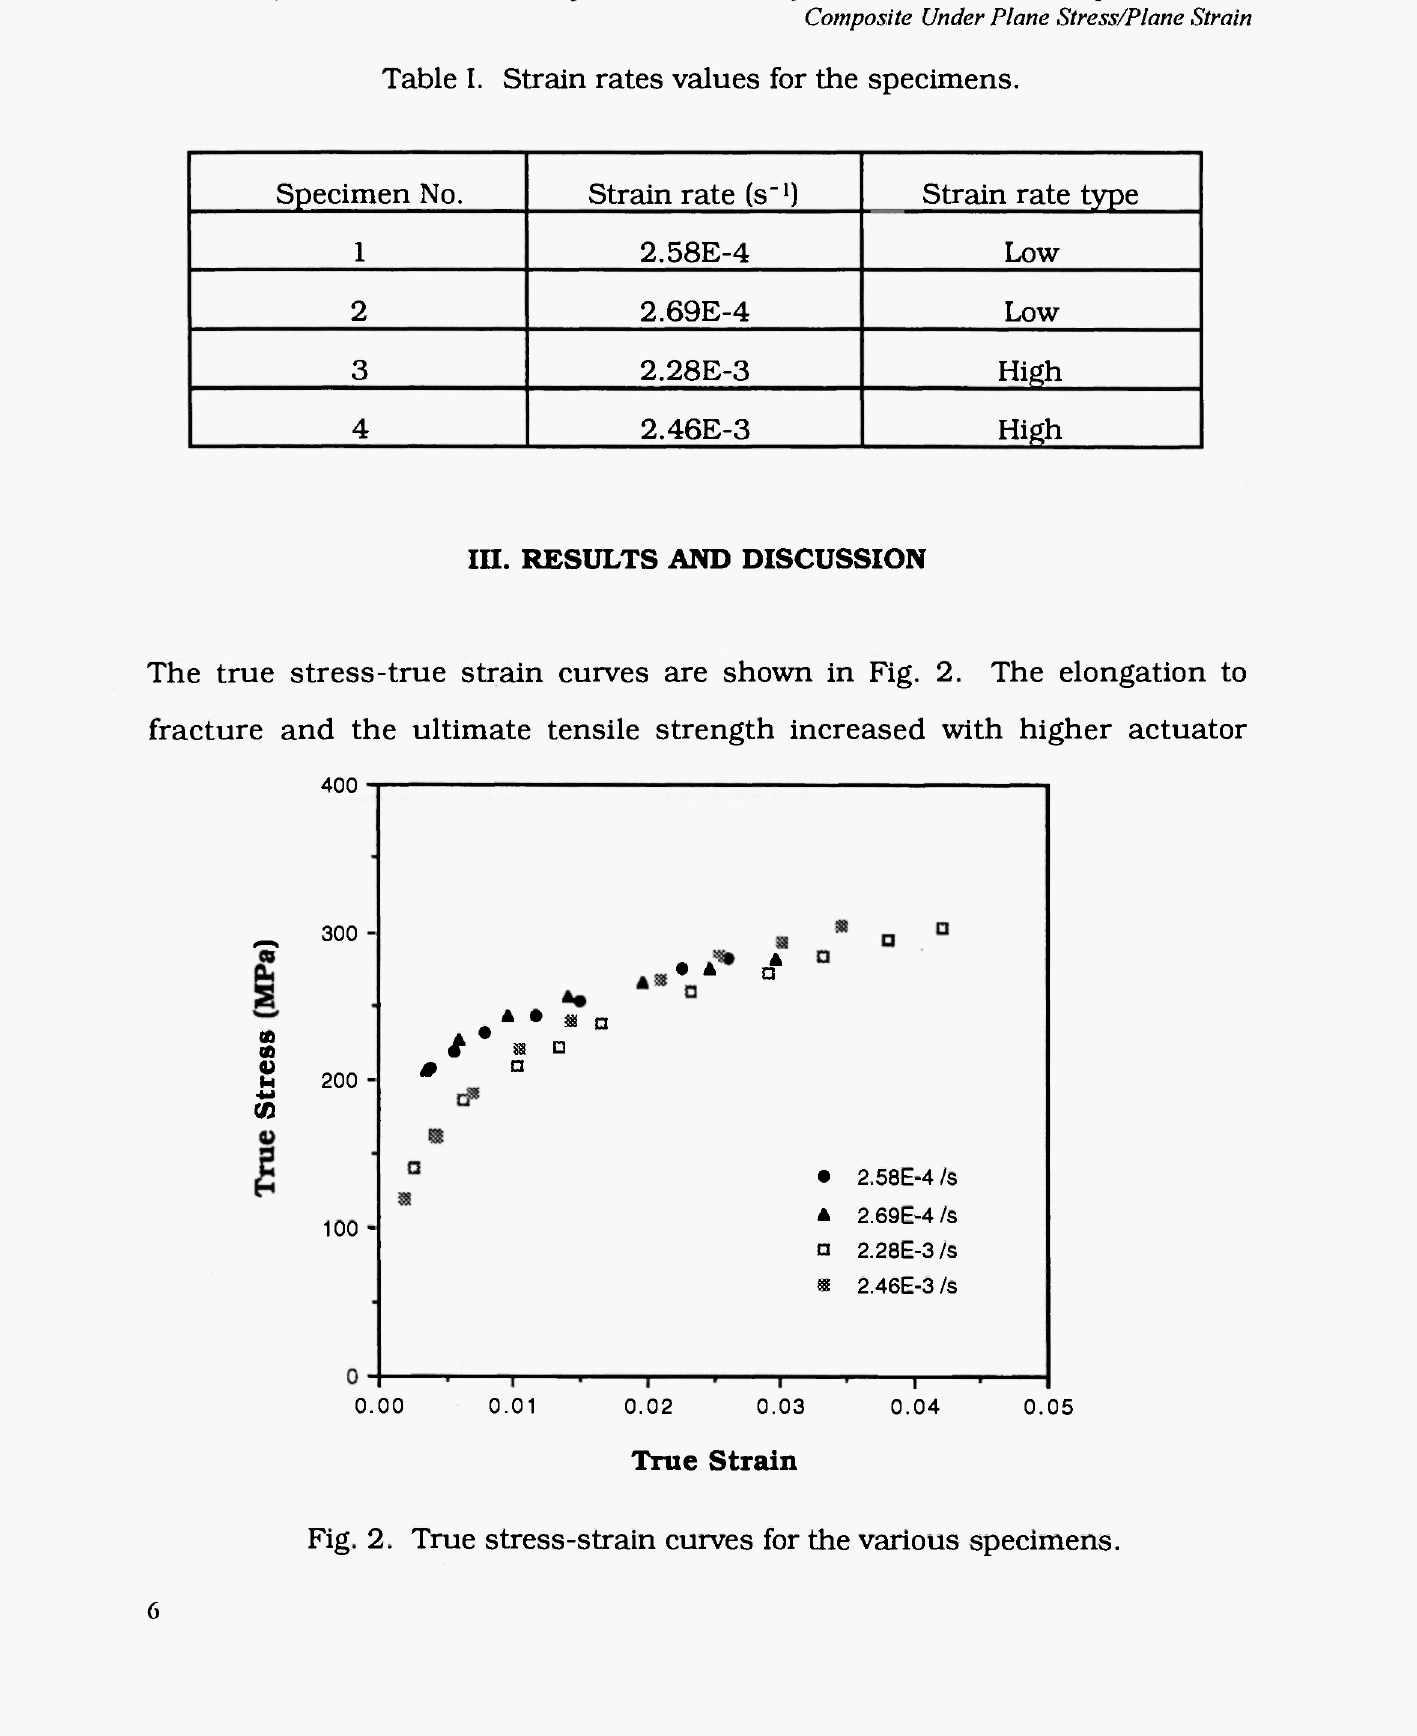
Table I. Strain rates values for the specimens.